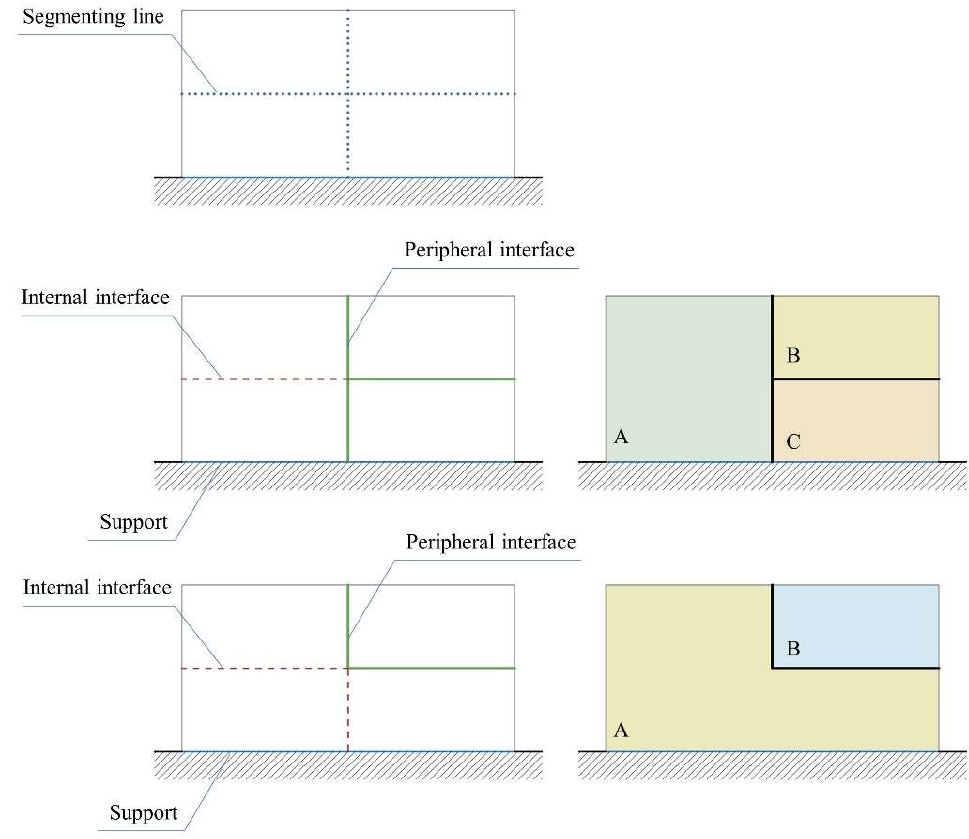
Figure 3. Segmenting a continuum along the segmenting lines; each generated model includes a set of internal and/or peripheral interfaces. Capital letters A, B, and C are used to enumerate the seg- ments.